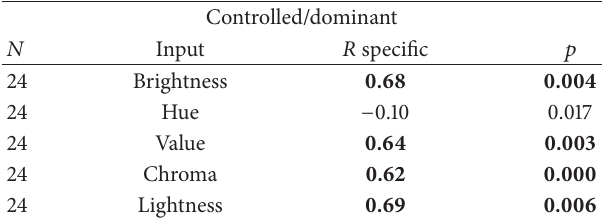
Table 3: Valence correlation.